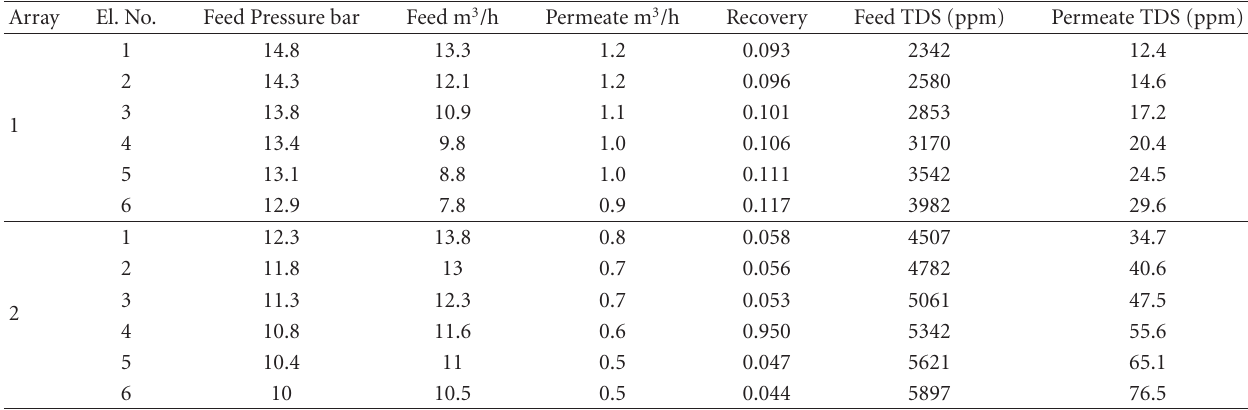
Table 4: Total results in details for the theoretical properties of each element in arrays 1 and 2. Array El. No.